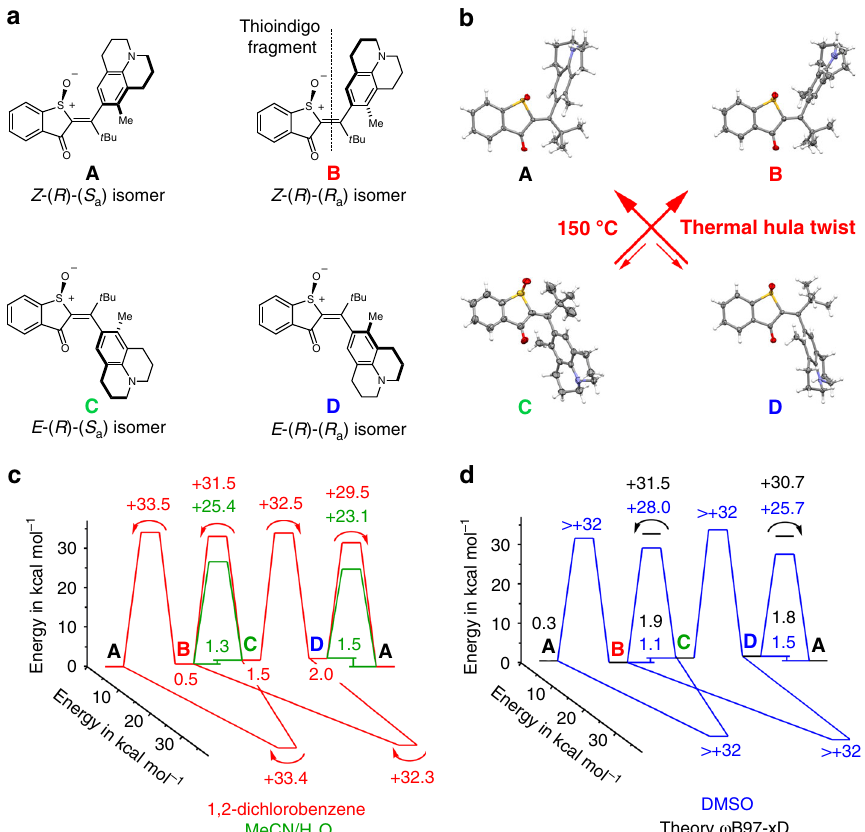
Fig. 1 Structures of isomers A to D of motor 1 and ground-state properties. a Schematic representation of the molecular structures of A to D . b Structures of isomers A to D in the crystalline state and thermal interconversion in solution. c Ground-state energy pro fi le of 1 experimentally determined in 12DCB- d 4 (red) and in acetonitrile- d 3 /D 2 O (8/2, green). d Ground-state energy pro fi le of 1 calculated at the ω -B97XD/6-311 G(d,p) PCM(DMSO) level of theory (black) and experimentally determined in DMSO- d 6 (blue)